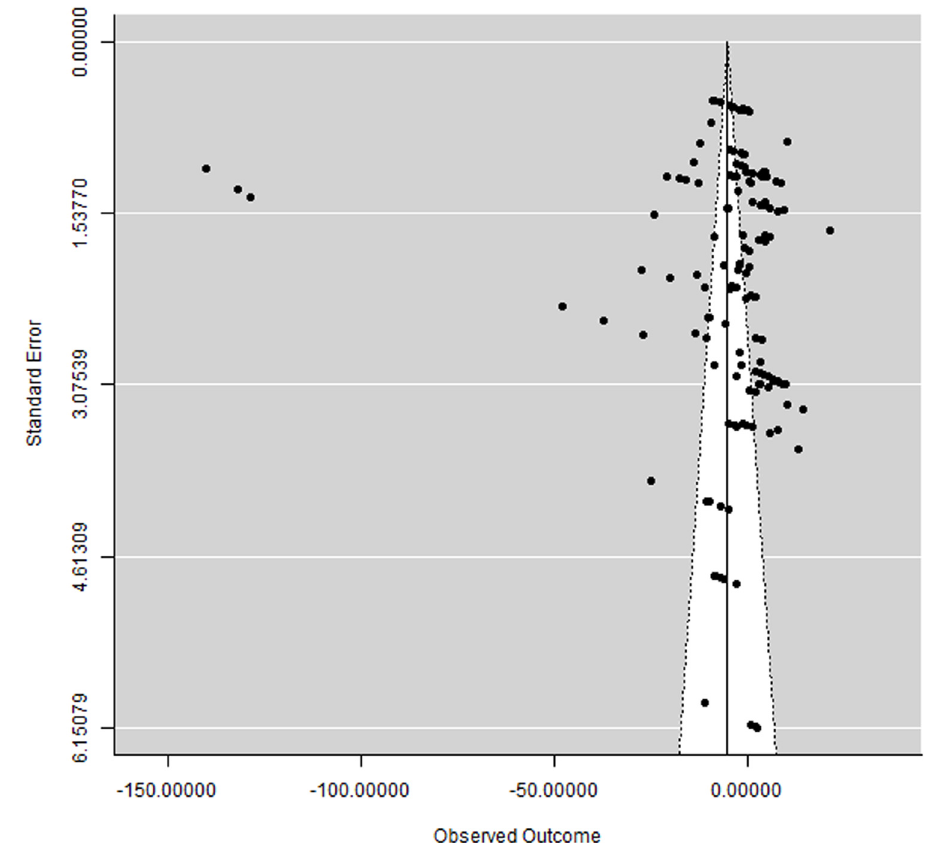
Figure 2: Funnel plots of the impact of cassava intervention on ADFI in broiler